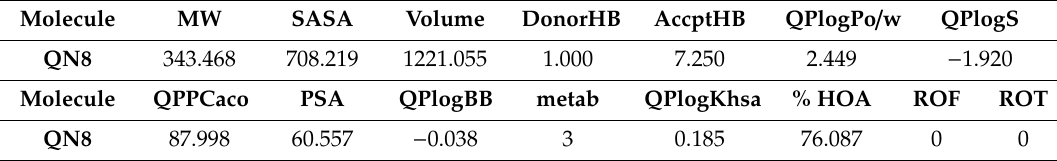
Table 2. Physico-chemical properties of compound QN8 calculated using QikProp. a.